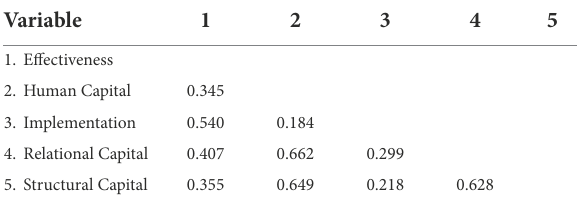
TABLE 5 Discriminant validity for the first-order constructs (HTMT